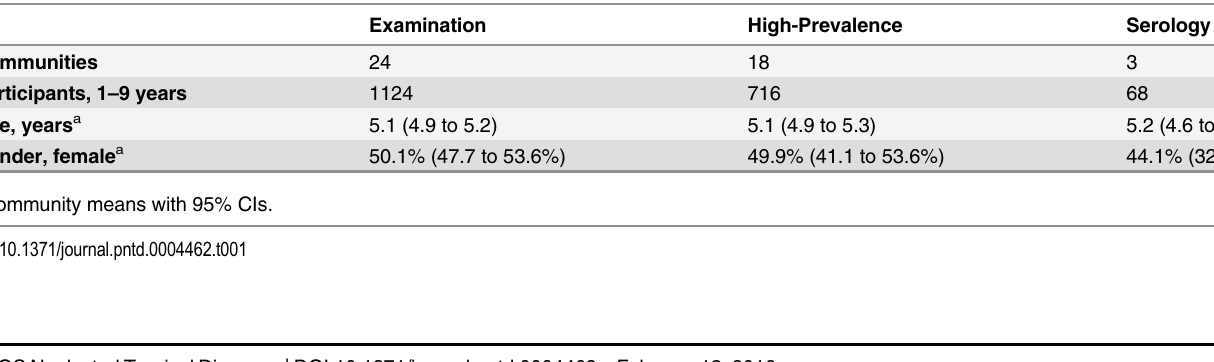
Table 1. Baseline characteristics of communities in examination, high-prevalence and serology